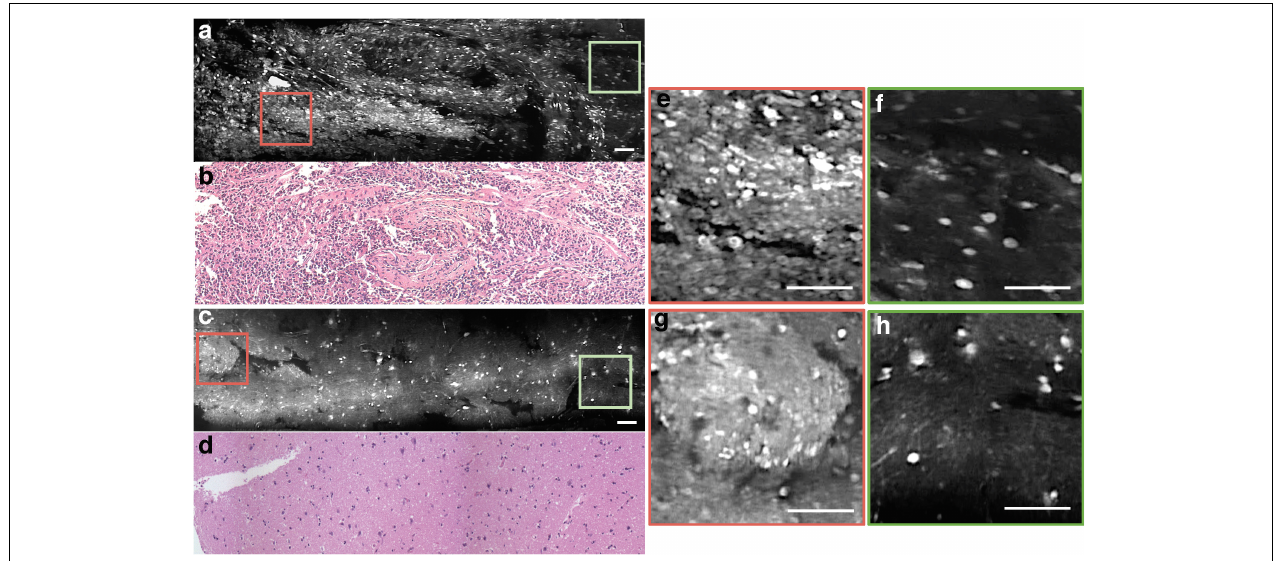
FIGURE 2 | Mosaicked images of human gliomas. (a) Mosaicked LS-DAC image of a human glioma with hypercellularity, along with corresponding H&E histology (b) . (c) Mosaicked LS-DAC image of human glioma with overall normal cellularity and cytoarchitecture, along with corresponding H&E histology (d) . While the large-area mosaics provide a non-ambiguous assessment of the two specimens, individual image frames from the glioma specimen (e,f) can present similar characteristics to those from the benign specimen (g,h) . Scale bars represent 100 µ m. LS-DAC, line-scanned dual-axis confocal; H&E, hematoxylin and